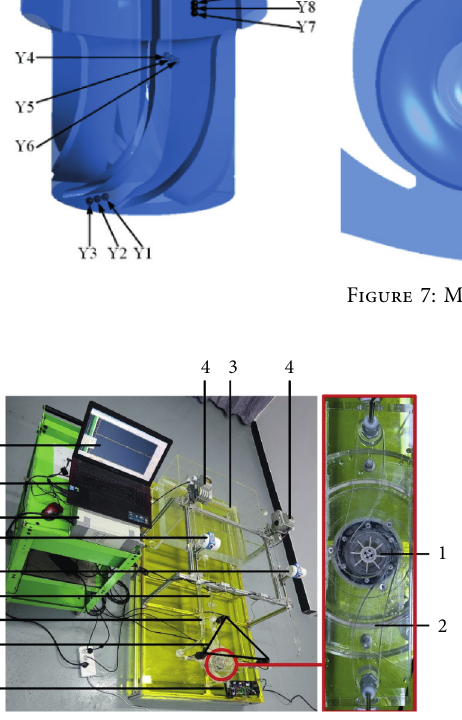
Figure 8: Dishwasher pump test system. (1) Impeller, (2) volute, (3) water tank, (4) electromagnetic valve, (5) turbine flowmeter, (6) inflow pipe, (7) outflow pipe, (8) pressure gauge, (9) motor speed controller, (10) data-acquisition system, (11) personal computer, and (12) software interface.